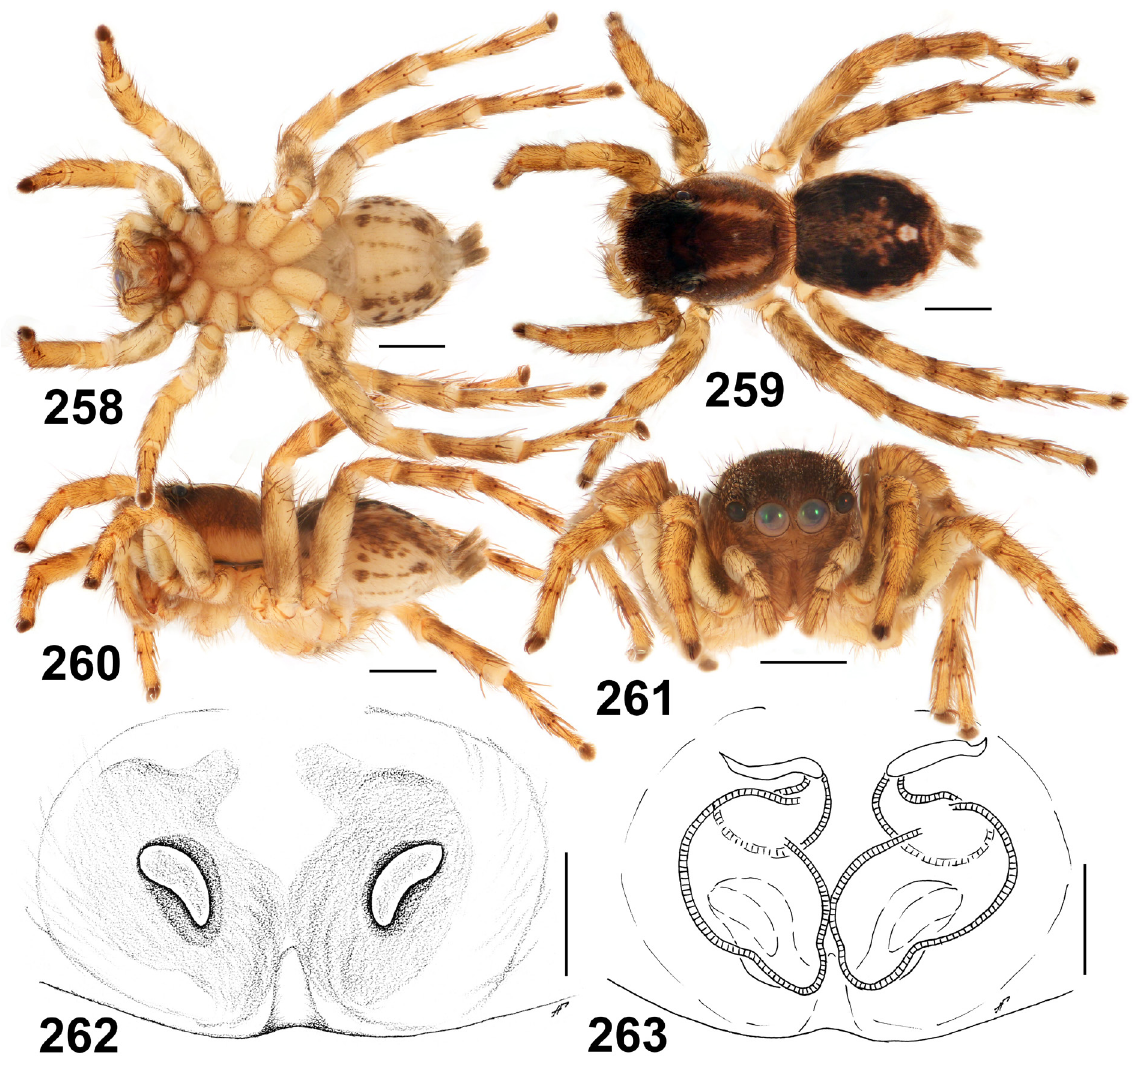
Figs 258–263. Stenaelurillus hirsutus Lessert, 1927, ♀ (paratype of Stenaelurillus cristatus Wesołowska & Russell-Smith, 2000) from Tanzania (Mkomazi GR). 258–261 . General appearance. 262 . Epigyne, ventral view. 263 . Spermathecae, dorsal view. Scale bars: 258–261 = 1 mm; 262–263 =